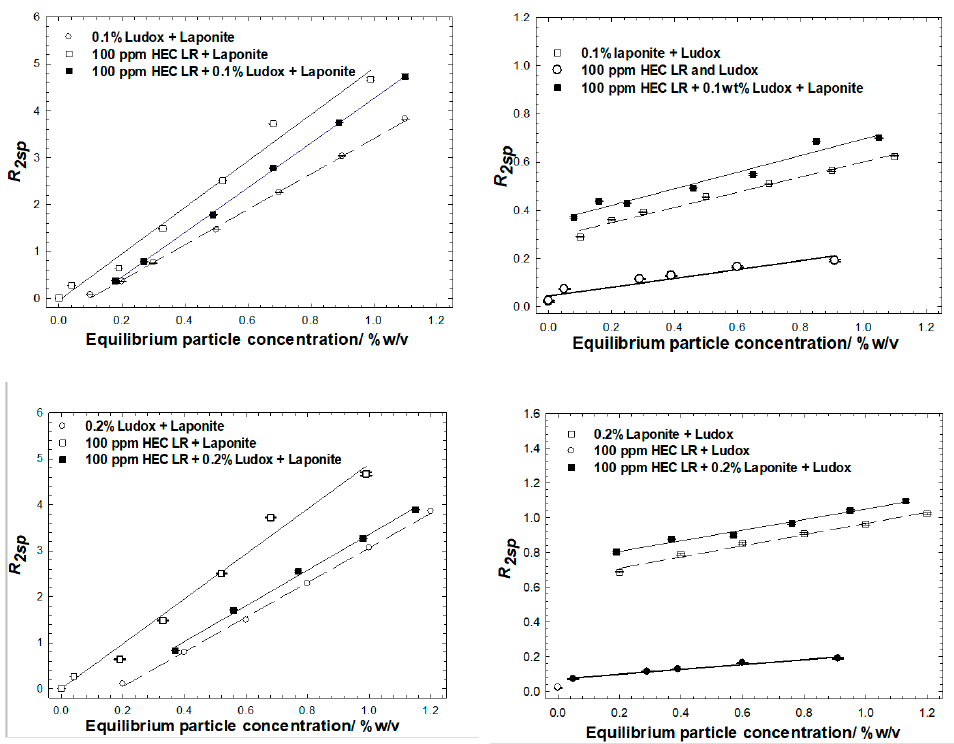
Figure 7. Solvent-specific relaxation rates of mixtures of HEC LR with Ludox and Laponite particles. Two series of experiments have been conducted, based on fixed concentrations of Ludox and Laponite; 0.1 wt% top row, 0.2 wt% bottom row; fixed Ludox concentration left hand column, fixed Laponite concentration, right hand column.